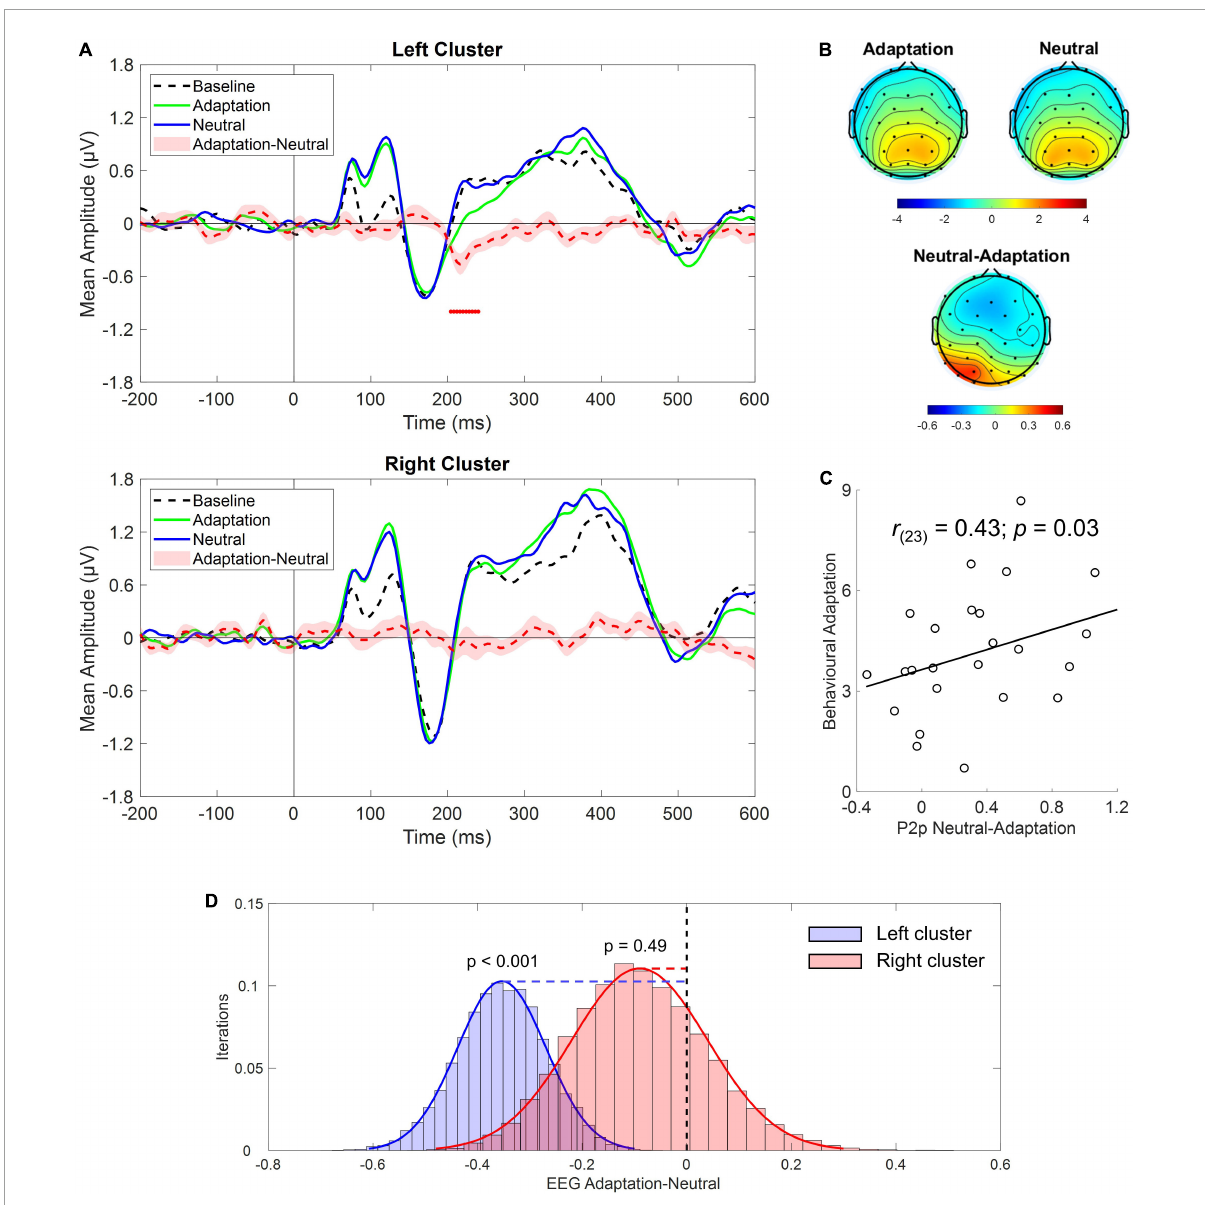
FIGURE4 (A) Event-related potentials (ERPs) response averaged across electrodes P3, P7, PO3, PO7, O1 (upper panel) and P4, P8, PO4, PO8, O2 (bottom panel) during Baseline (dotted black), Adaptation (green solid), and Neutral (blue solid) conditions. Red dotted curve depicts the temporal distribution of the difference (plus standard errors, light red shading) between Adaptation and Neutral conditions while red dots depict the time interval of statistical significance. (B) Scalp topographies depicting the spatial distribution within the time range of significance for the Adaptation, Neutral and the difference between the two. (C) Correlation between behavioral adaptation magnitude and electrophysiological response difference between the Adaptation and the Neutral conditions obtained in the left cluster of electrodes. (D) Bootstrap distributions (20,000 iterations) of the EEG difference between Adaptation and Neutral conditions within the time range of the P2p component for the left (blue histogram) and the right cluster (red histogram) of electrodes. The null hypothesis (i.e., no difference between Adaptation and Neutral conditions), indicated by the black vertical dotted line, falls outside the distribution for the left but not for the right